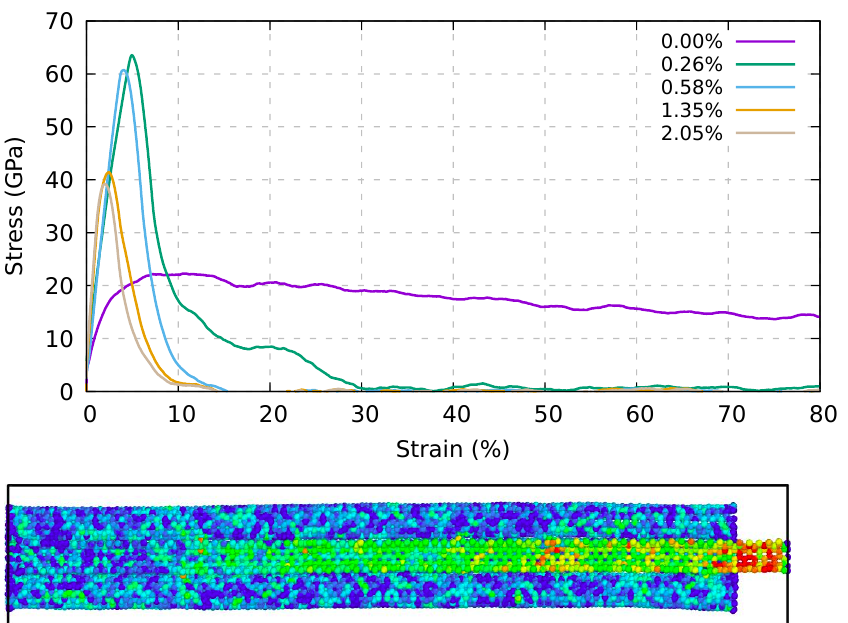
Figure 3. Top panel: pull-out stress for the central nanotube from the seven (6,6) CNT bundles with different percentages of linkers at a constant pull-out velocity of 1.0 Å/ps. Bottom panel: cross section of the bundle with a linker percentage of 0.26%; the color coding shows the von Mises stress distribution that decreases as the distance from the pull-out extremity